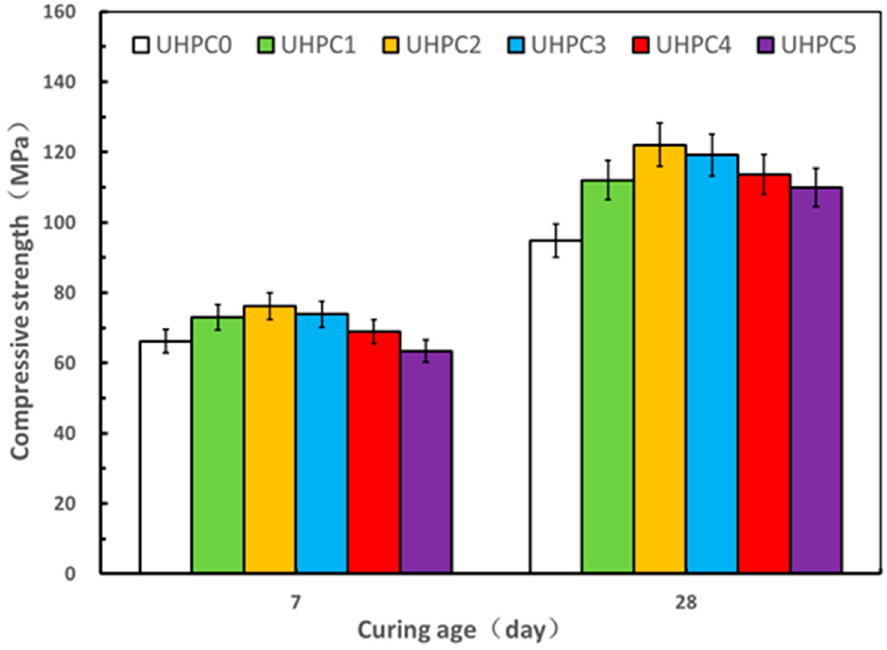
Figure 5. Effect of GO nanosheets on compressive strength under standard curing.